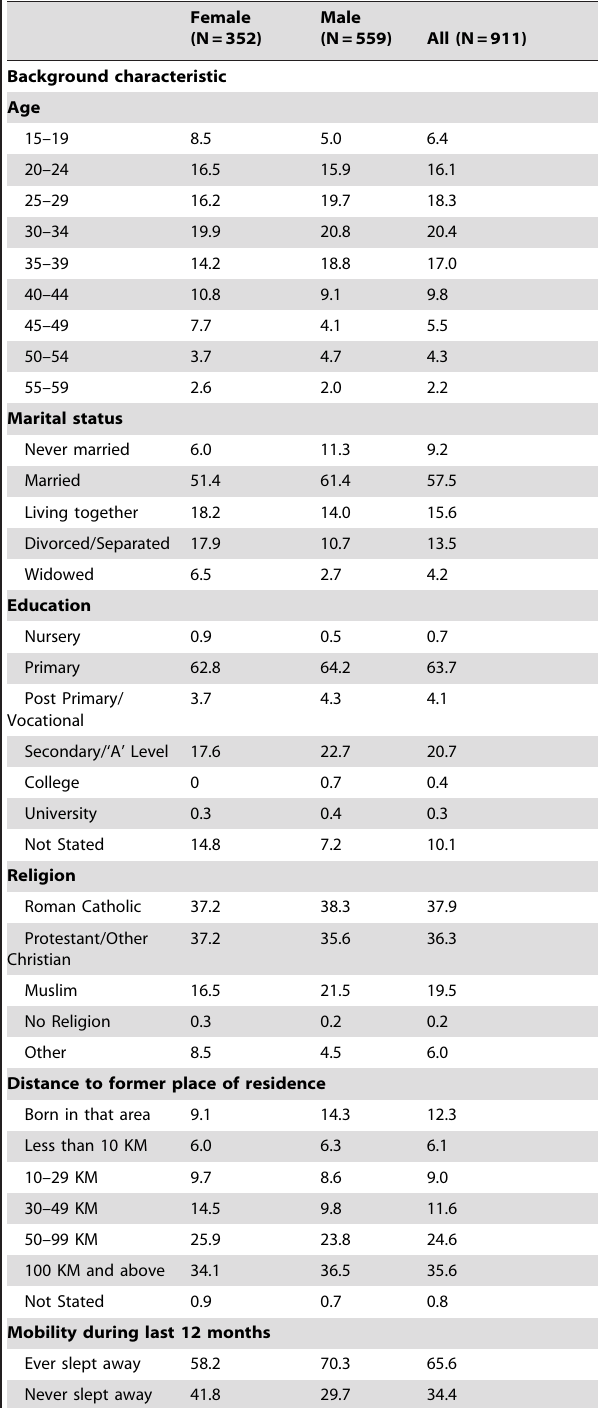
Percent distribution of women and men by selected background